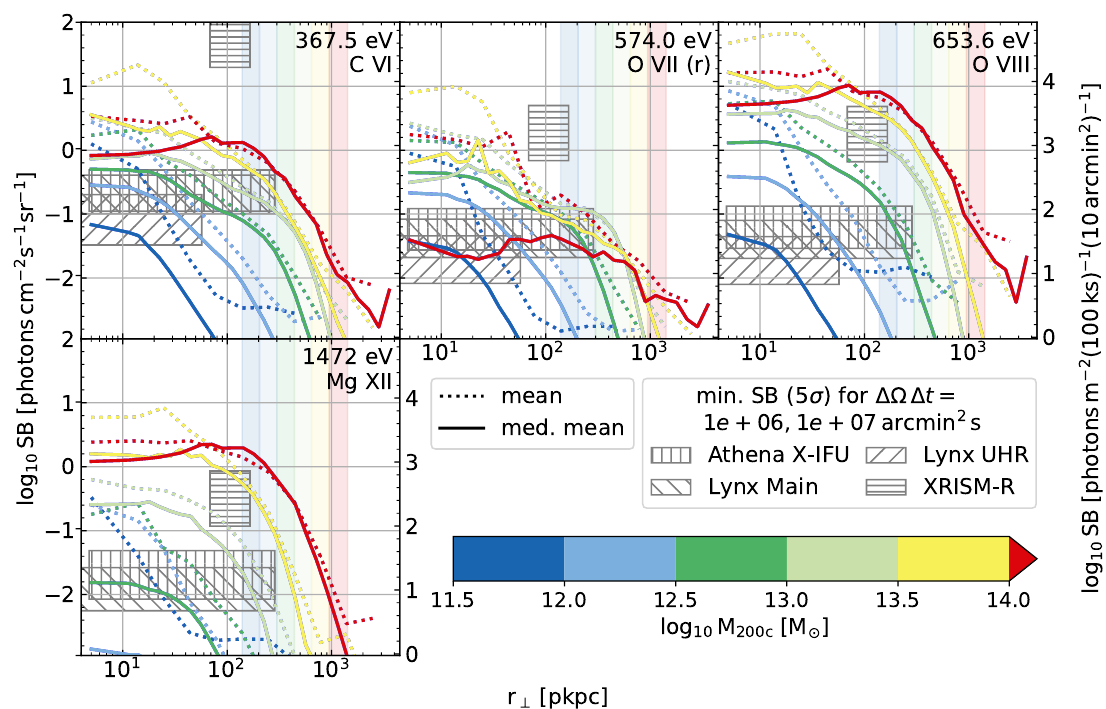
Figure 17. X-ray line emission predictions from the EAGLE simulation via Nastasha Wijers (in prep.) demonstrating the detectability by XRISM , Athena , & Lynx space-borne micro-calorimeters as a function of impact parameter from the central galaxy. Lines are colored by halo mass with light green and yellow corresponding approximately to low-mass and high-mass groups. Faded vertical stripes indicate R 200 for each halo mass. High-mass groups are detectable by XRISM in O VIII and Mg XII at 100 kpc, while low-mass groups are detectable only in O VIII . Athena and Lynx should measure IGrM line emission for all group halos with high spatial